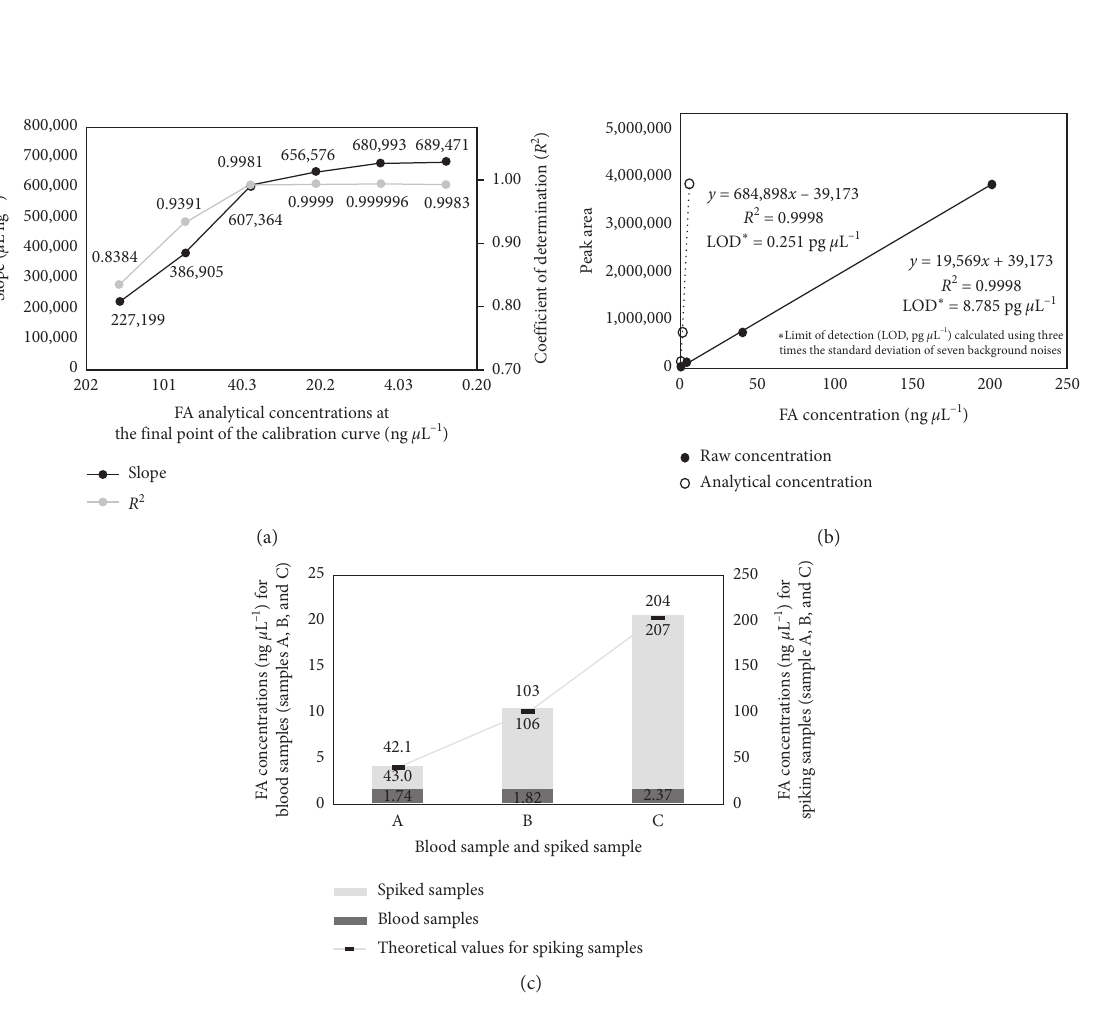
Figure 3: FA analysis in standards and blood samples. (a) Exp 1a: FA calibration in different concentration ranges. (b) Exp 1b: FA calibration and limit of detection. (c) Exp 2 and 3: analysis of spiked and unspiked blood